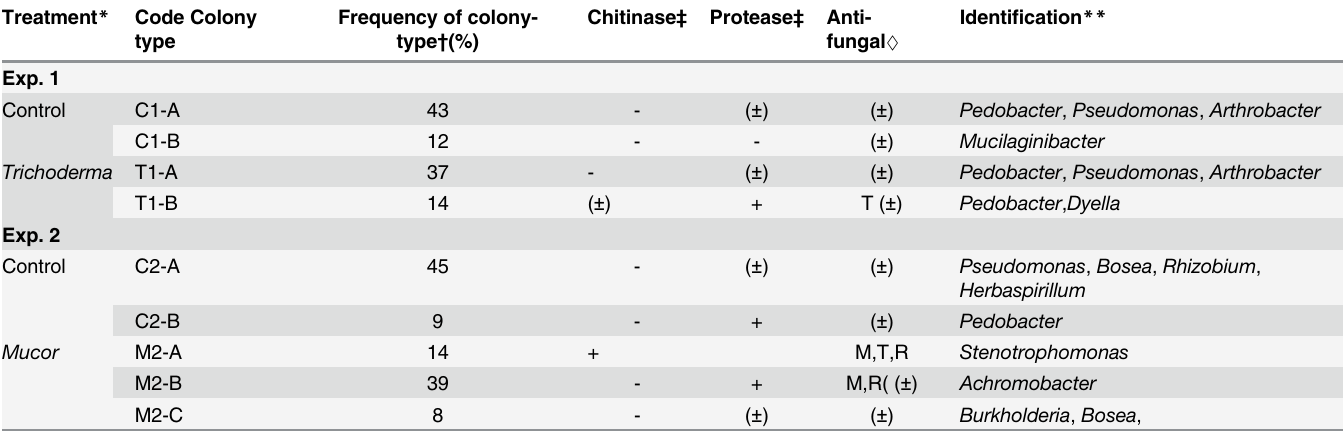
Table 1. Identification and (potential) antifungal properties of rhizosphere bacteria representing the most dominant colony morphologies in the rhizosphere of Carex arenaria in sand microcosms with or without the presence of the fungi Trichoderma harzianum strain PvdG2 (experiment 1) or Mucor hiemalis strain BHB1 (experiment